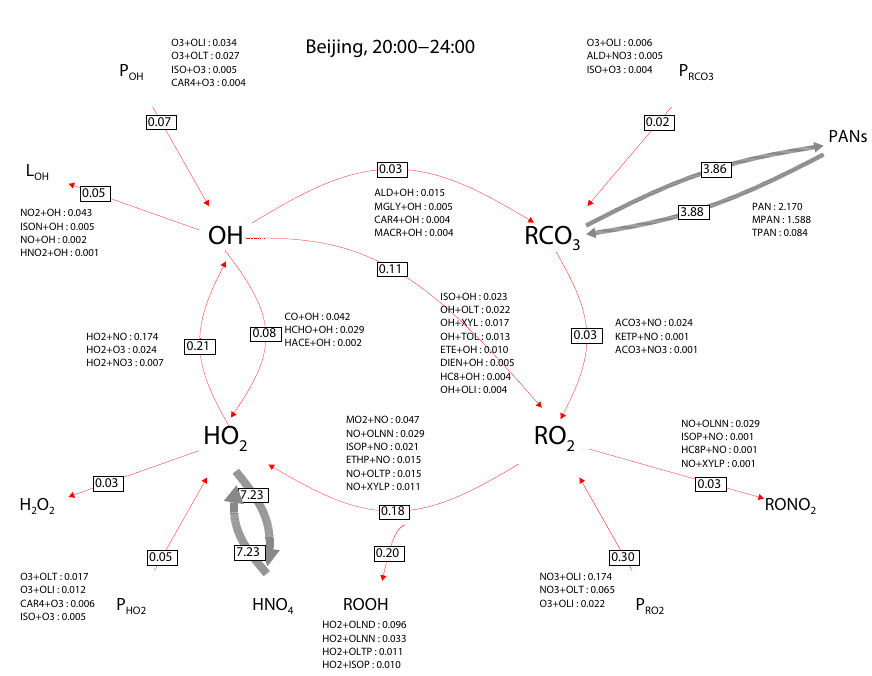
Figure 8. Mean RO x production, conversion, and destruction rates calculated by the base model (M0) for CAREBEIJING2006 conditions during 20:00–24:00CNST. The thickness of the arrows represents the relative magnitude of the reaction rates given in ppbh − 1 .